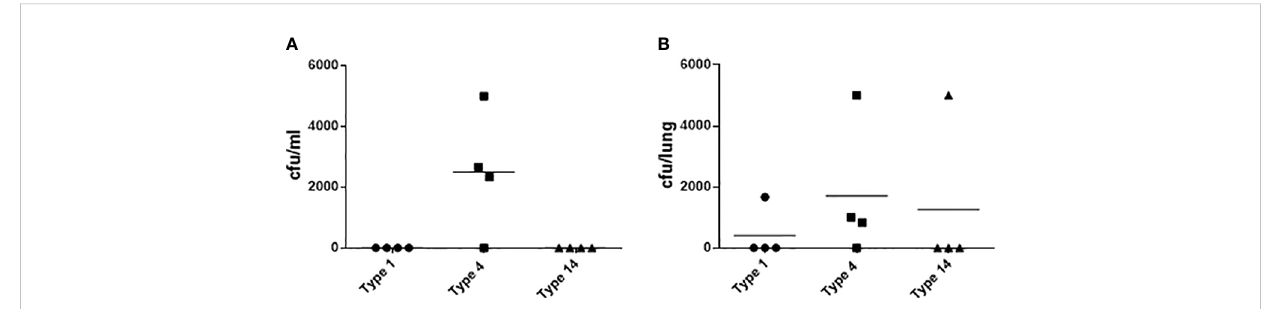
FIGURE 2 Microbiological outcomes in 10 week old female C57BL/6J mice 24 hours after intranasal instillation of S. pneumoniae . Bacteria in blood (A) and lung homogenates (B) following infection with 10 7 cfu of type 1, 4 or 14 pneumococci